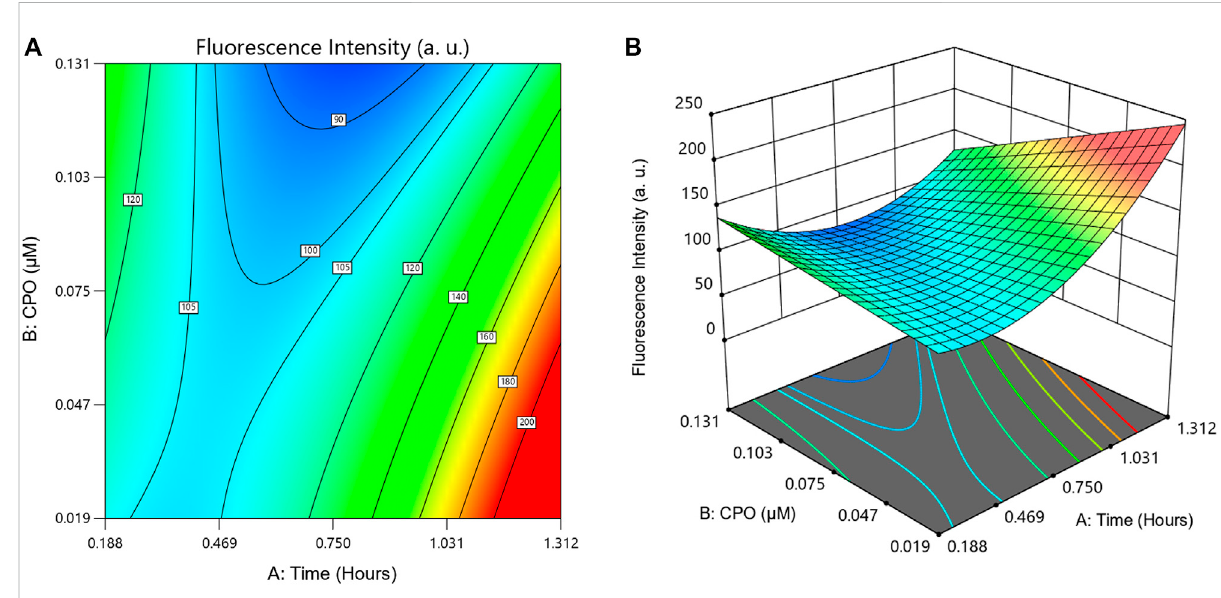
FIGURE 2 (A) Contour plot and (B) response surface plot of the interaction among CPO concentration and time reaction at 1.7 mM H 2 O 2 in relation to fl uorescence intensity of ampicillin